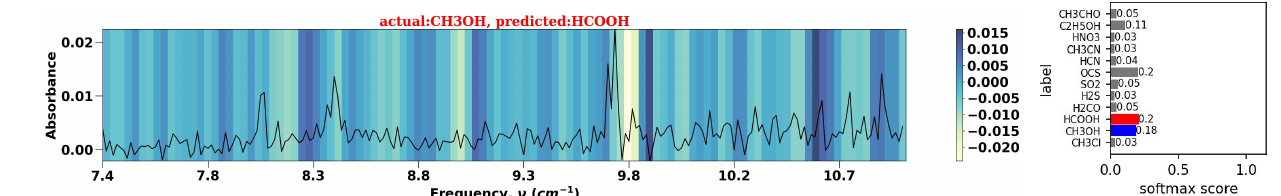
Figure 17. Class activation map for the classification of experimental spectra number 17. The spectra is for methanol at 1 Torr but is misclassified as formic acid. The corresponding softmax scores are shown next to the class activation